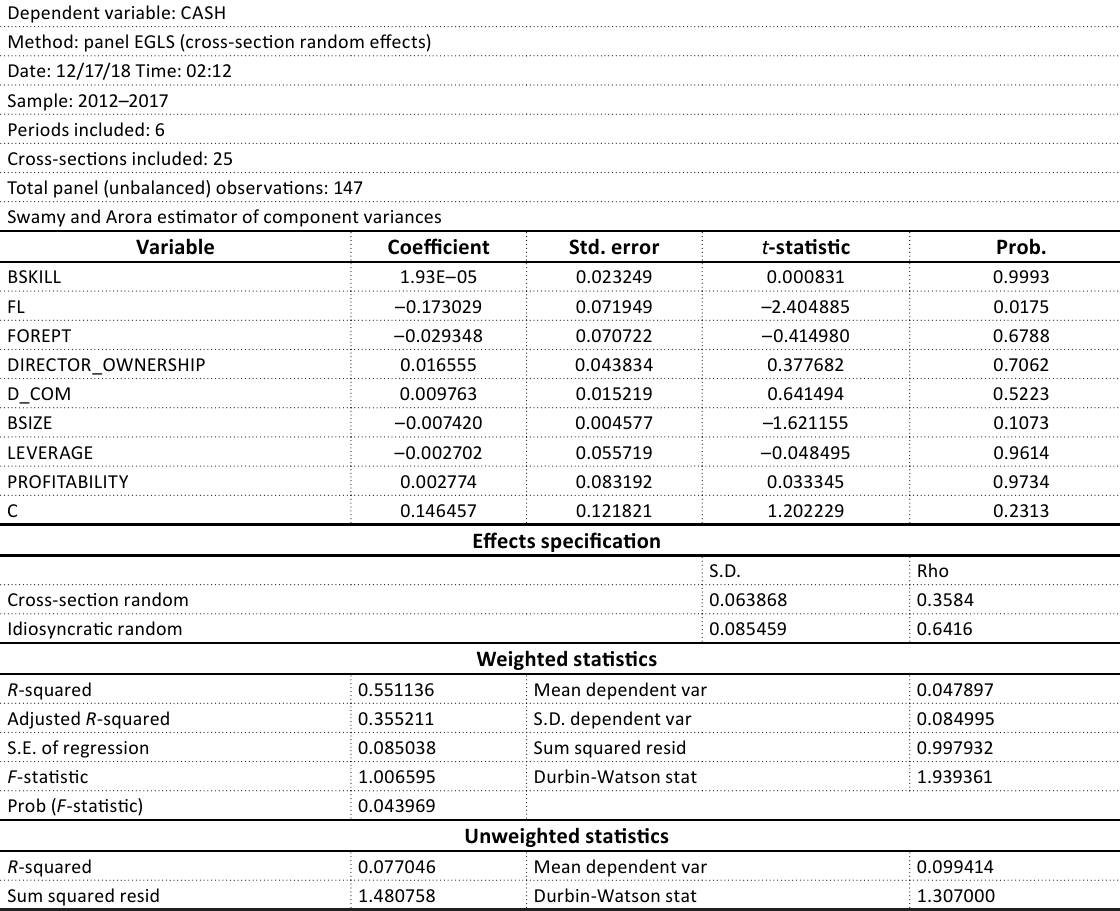
Table A1. Random effect regression